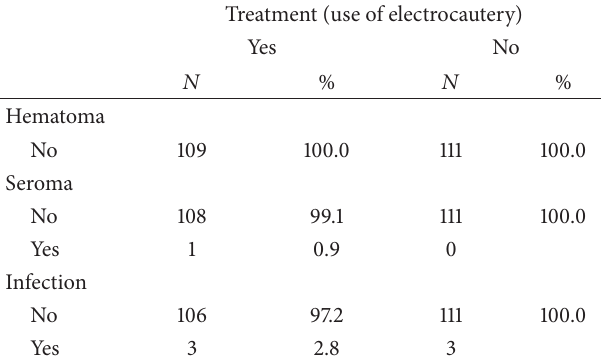
Table 3: Surgical scar complications between days 7 and 10 after C- section with and without the use of electrocautery.